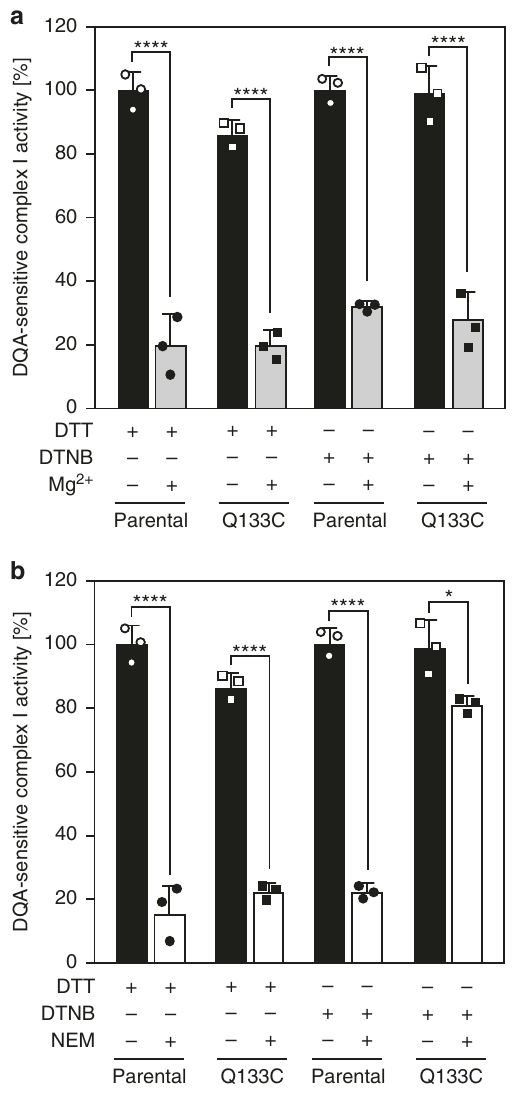
Fig. 2 Fixing loop TMH1-2 ND3 does not interfere with complex I activity and A/D transition. Mitochondrial membranes from parental and mutant strains were incubated with 5 mM dithiothreitol (DTT) or 0.1 mM 5,5 ′ - dithiobis-2-nitrobenzoic acid (DTNB) for 5 min at room temperature. Complex I activities were measured in the absence and presence of 5 mM MgCl 2 ( a ) or 2 mM n -ethylmaleimide (NEM) ( b ). In all cases, 1 mM decylubiquinone (DBQ) was added to the samples before the reaction was started by the addition of DBQ activity buffer containing 110 µ M dNADH and supplemented with either 5.5 mM MgCl 2 or 2.2 mM NEM. The fi nal concentrations of DBQ and membranes were 100 µ M and 50 µ g ml -1 , respectively. n -Decyl-quinazoline-amine (DQA)-sensitive dNADH:DBQ oxidoreductase activities in Q133C PSST normalized to their respective controls (parental) are indicated. Activities were measured at pH 8.5 since the inhibition of the D-form by divalent cations is stronger at alkaline pH values, as well as it favors the labeling of the exposed C40 ND3 by NEM. Data from three independent experiments (mean ± s.d.) are shown. * p